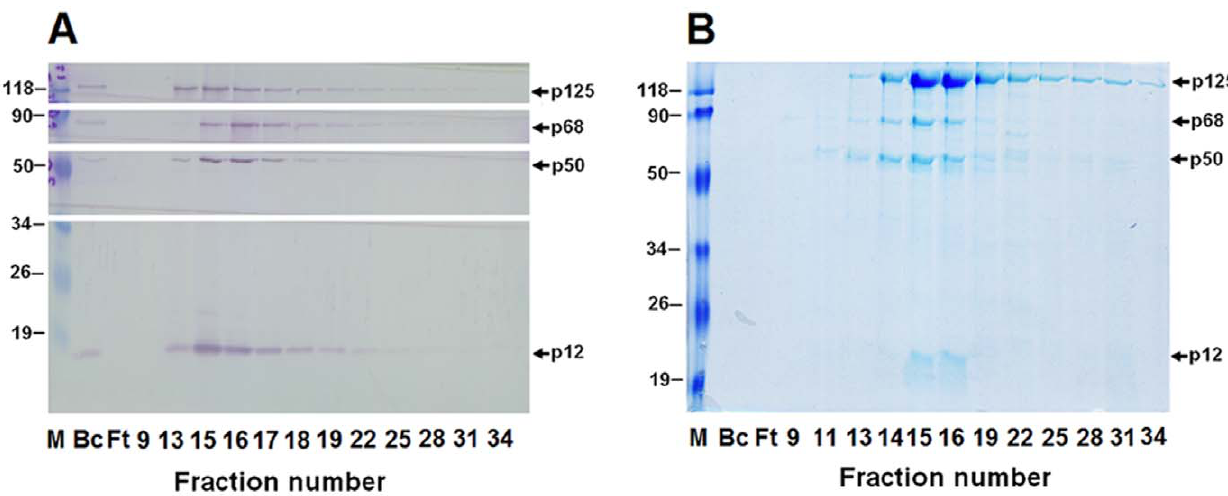
Figure 5. Purification of recombinant pol d heterotetramer by Mono Q chromatography from supernatant fraction of hemolymph. The peak fractions (fractions 6–21) from the immunoaffinity chromatography step in which the column was applied with supernatant fraction of hemolymph were combined and passed through a Mono Q column. The lysates (BC), flow-through (FT), and eluted fractions were analyzed by 12.5% SDS-PAGE followed by Western blotting (panel A) or Coomassie Blue staining (panel B).